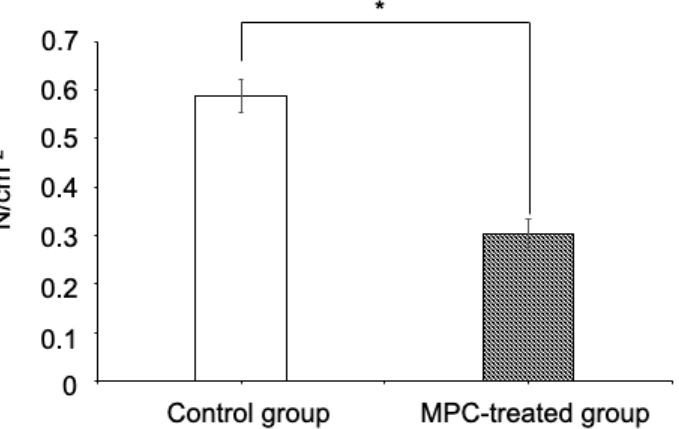
Figure 3. Effect of MPC-coated wires on frictional force. Data are presented as mean ± SEM of three independent experiments ( n = 3). The Mann–Whitney U test was used for comparisons between groups. p value < 0.05 was considered significant. * p < 0.05. MPC, 2-methacryloyloxyethyl phosphorylcholine; SEM, standard error of the